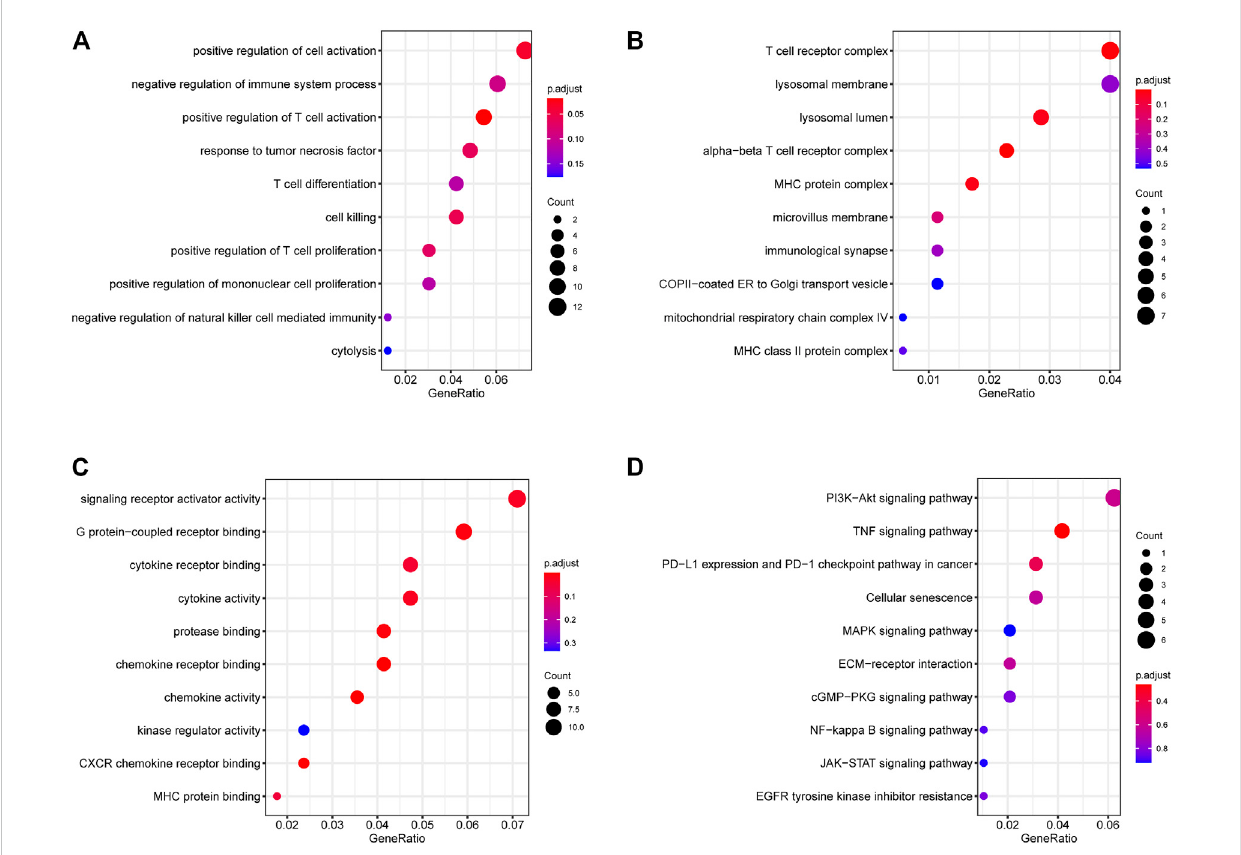
FIGURE 2 GO/KEGG functional enrichment of DEGs. (A) BP (biological process) (B) MF (molecular function) (C) CC (cellular component) (D) KEGG (Kyoto Encyclopedia of Genes and Genomes) functional enrichment. Signaling pathways related to immunity, autophagy and